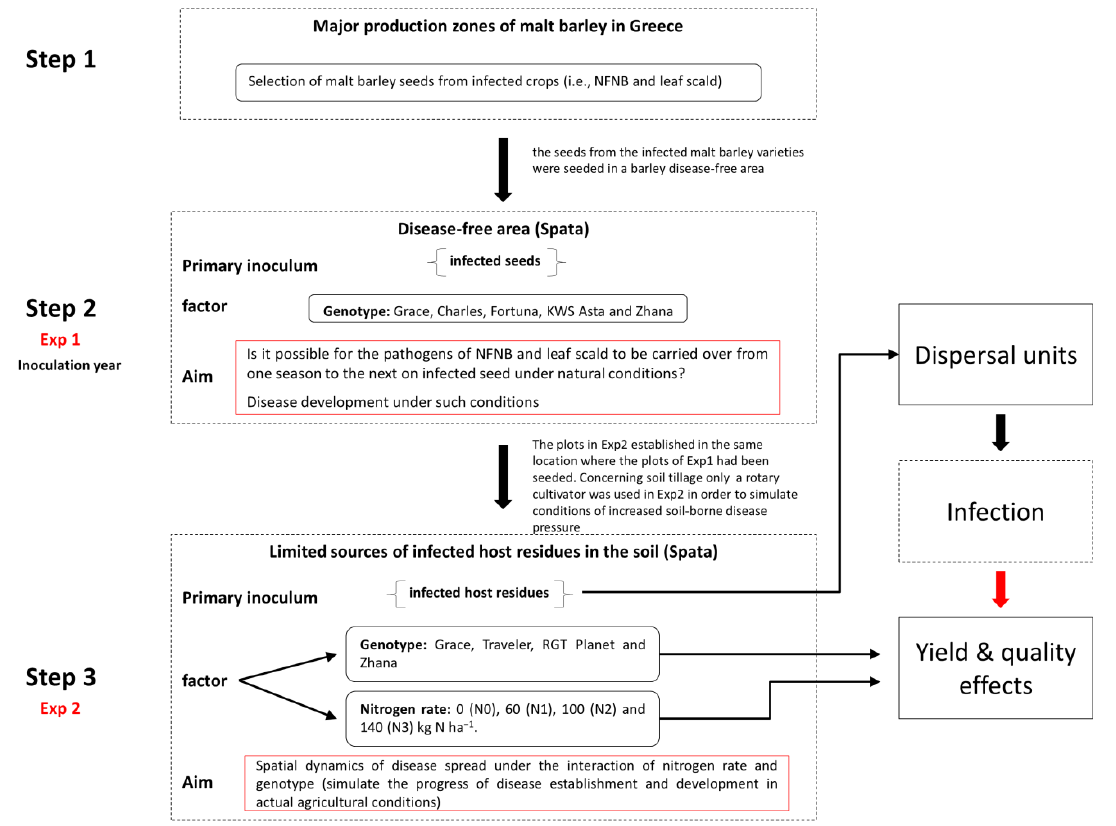
Figure 1. Conceptual diagram of the methodological approach.